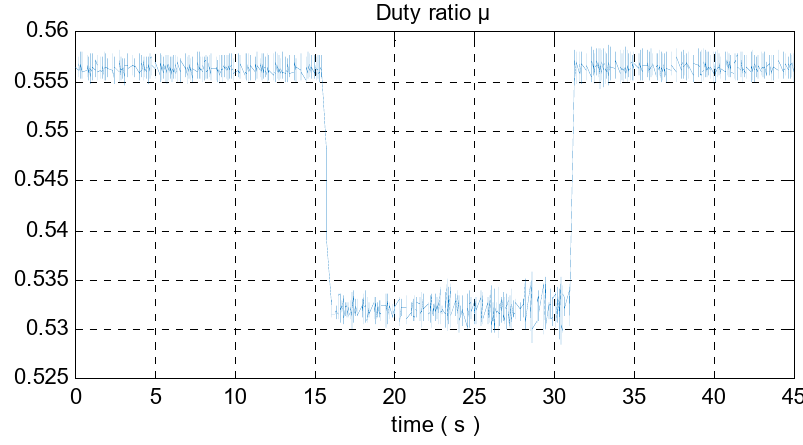
Figure 31. Duty ratio µ.